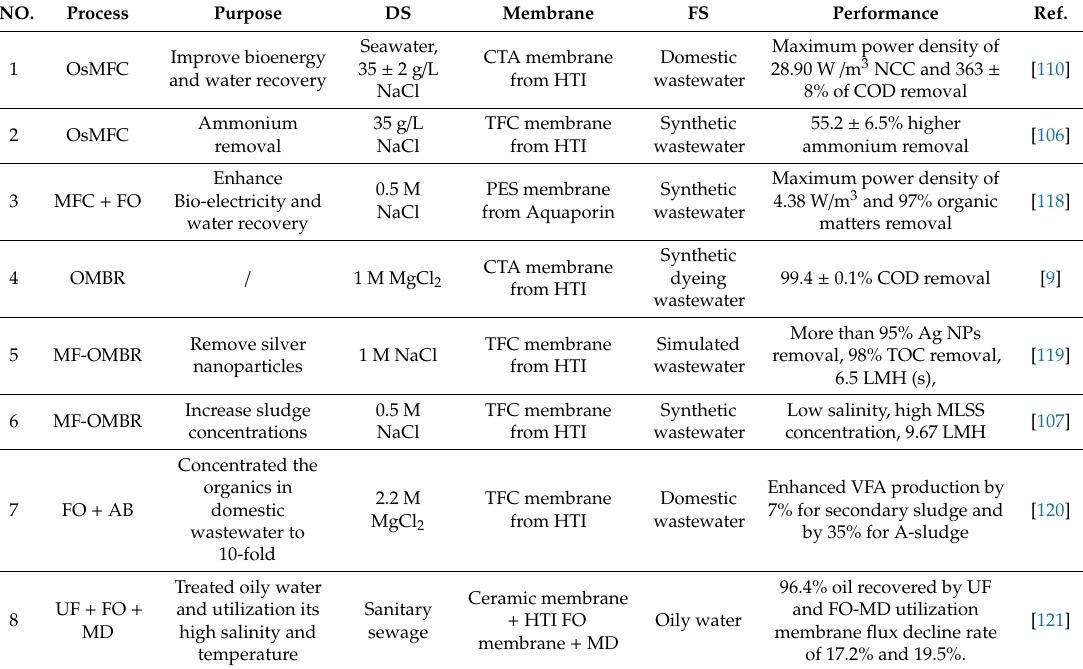
Table 5. List of recent integrated FO system mentioned in